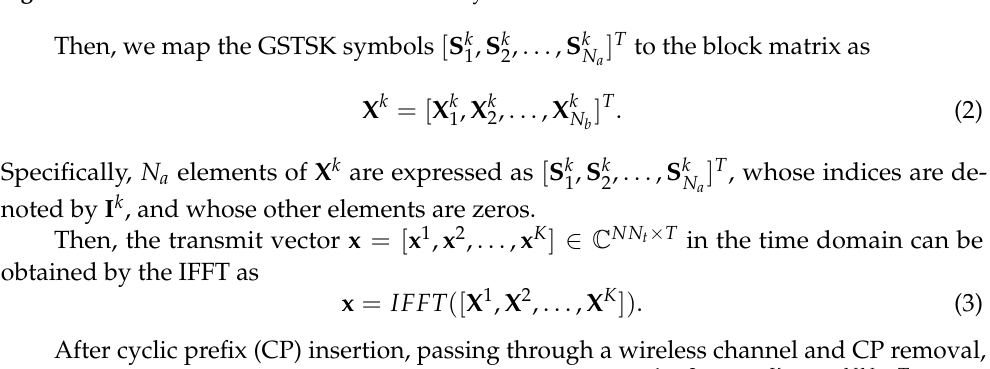
Figure 1. Transmitter structure of the GSTFIM